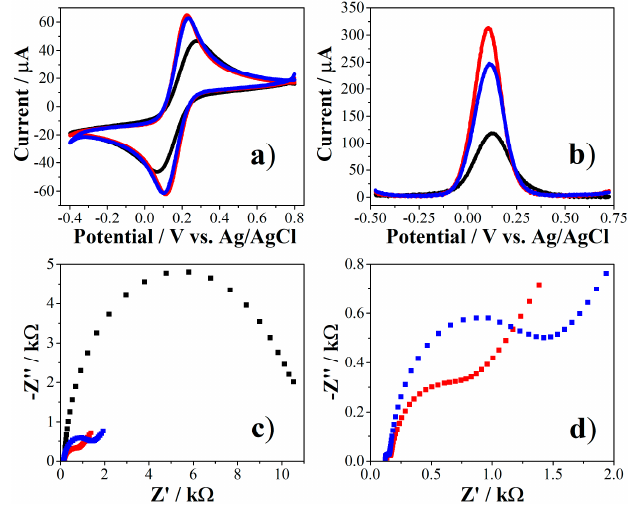
Figure 8. Electrochemical characterization of the screen-printed electrodes modified with AuNPs and PEPTIR-1.0 by CV ( a ), SWV ( b ) and EIS ( c ) during the construction of the biosensor. In all cases the black, red and blue lines or dots correspond to SPE, SPE/AuNPs and SPE/AuNPs/PEP, respectively. EIS results for SPE/AuNPs and SPE/AuNPs/PEP are presented expanded in ( d ) for clarity. 10 mM of [Fe(CN) 6 ] − 3/ − 4 in 0.1 M of KCl aqueous solution for CV and SWV. 2.0 mM of [Fe(CN) 6 ] − 3/ − 4 for EIS.